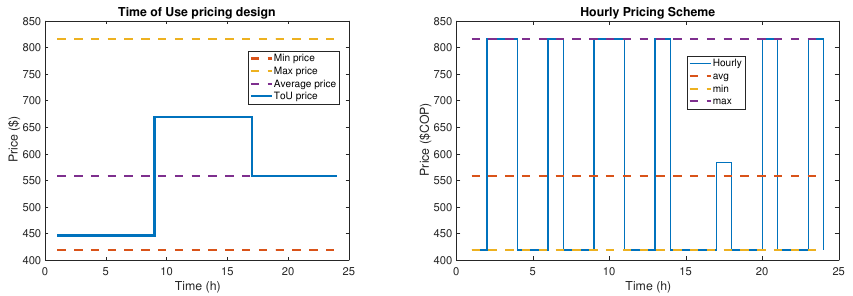
Figure 7. Pricing Scheme